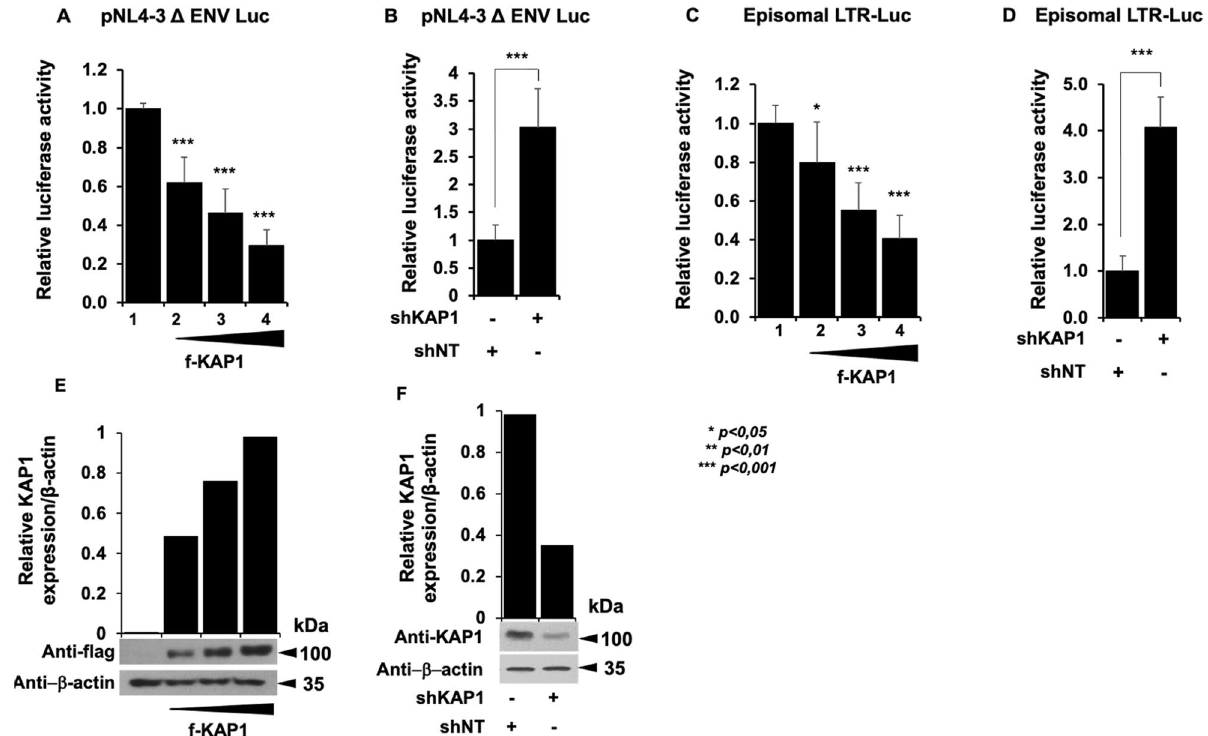
Figure 1. KAP1 suppresses HIV-1 expression ( A – D ) Microglial cells were transfected with the pNL4-3 Δ ENV Luc vectors ( A , B ) or with episomal vector LTR-Luc ( C , D ) in the presence of an increasing dose of KAP1 ( A , C ), or with a KAP1 knockdown (shKAP1) ( B , D ). Luciferase activity was measured 48 h post-transfection and after lysis of the cells. Luciferase values were normalized to those obtained with LTR-Luc or pNL4-3 Δ ENV Luc alone. A t-test was performed on 3 independent experiments P (* P < 0.05, ** P < 0.01, *** P < 0.001). ( E ,F) Overexpressions of KAP1, as well as knockdown efficiencies, were validated by Western blotting. KAP1 expression levels were quantified and presented relatively to β-actin expression, using image J software. Full- length blots are presented in Supplementary Figure 1.